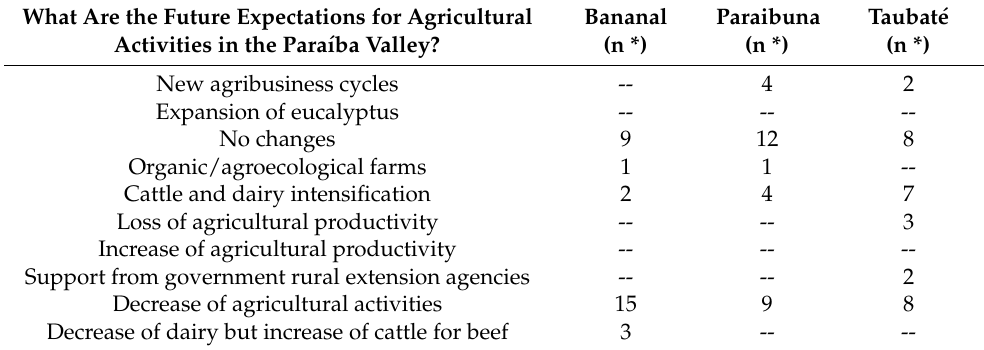
Table 5. Question addressed to interviewees about future expectations on agricultural activities in the Para í ba Valley, Brazil.